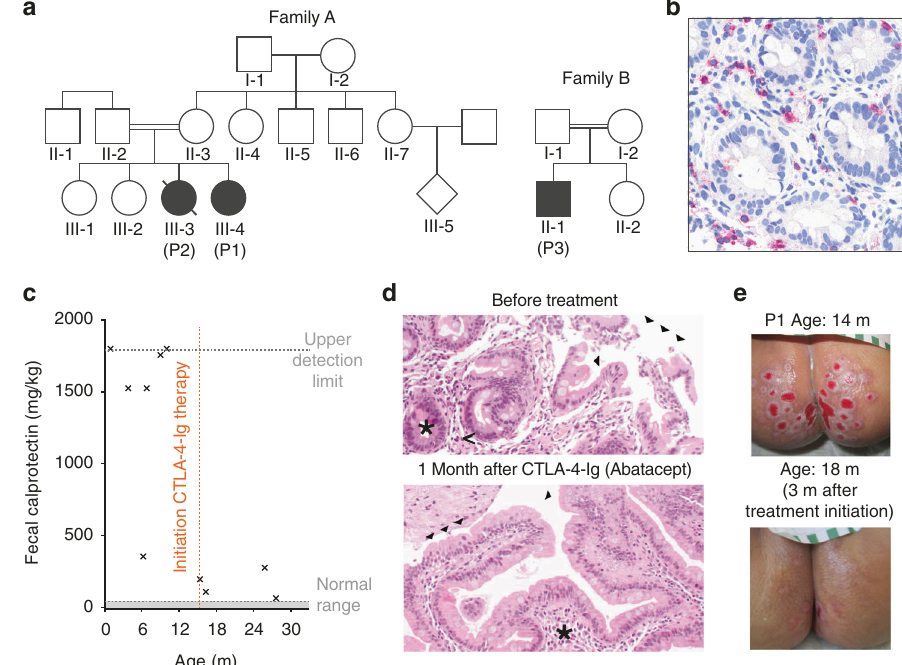
Fig. 1 Systemic autoimmunity in three patients from two families. a Pedigree of families A and B. Filled symbols – affected patients (P). b Colon biopsy of P1 reveals T-cell in fi ltration (red: anti-CD3). c Fecal calprotectin values reveal therapy-dependent reduction of bowel in fl ammation in P1. d Duodenal biopsies at the age of 5 months (top) showed incomplete villous atrophy with villi focally reduced and plump (closed arrows). The in fl ammatory in fi ltrate contains clusters of eosinophilic granulocytes (lined arrows) and only few crypts with isolated apoptotic fi gures (asterisk). At the age of 16 months (bottom, 1 month of therapy with Abatacept, see Fig. S1e) duodenal biopsies showed presence of villi (closed arrows) and no signs of acute in fl ammation in the lamina propria (asterisk) of P1. e Perianal fi ssures of P1 before (top) and after (bottom) therapy initiation present a marked improvement of patient quality of